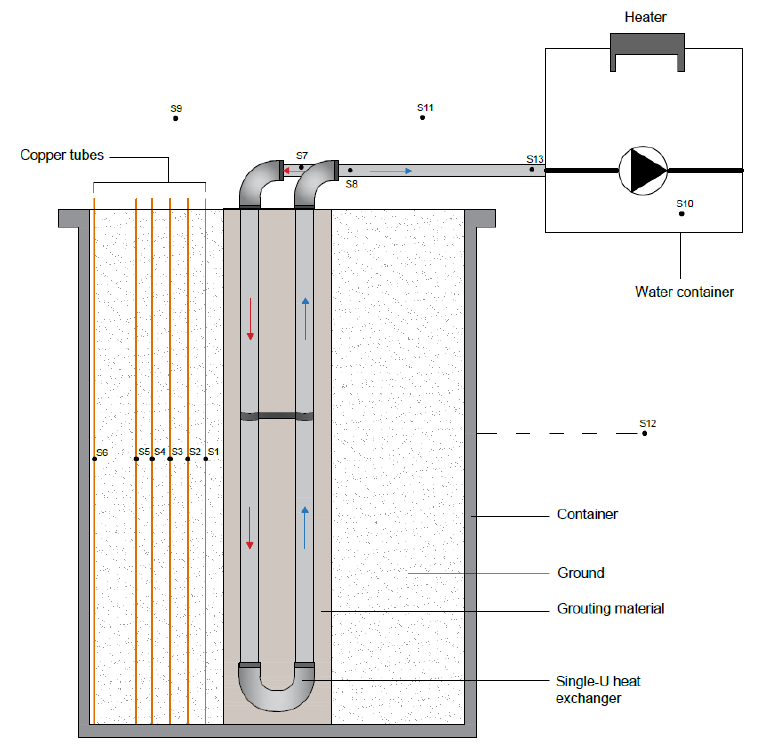
Figure 1. Schema of the geothermal setup reproduced in the laboratory.